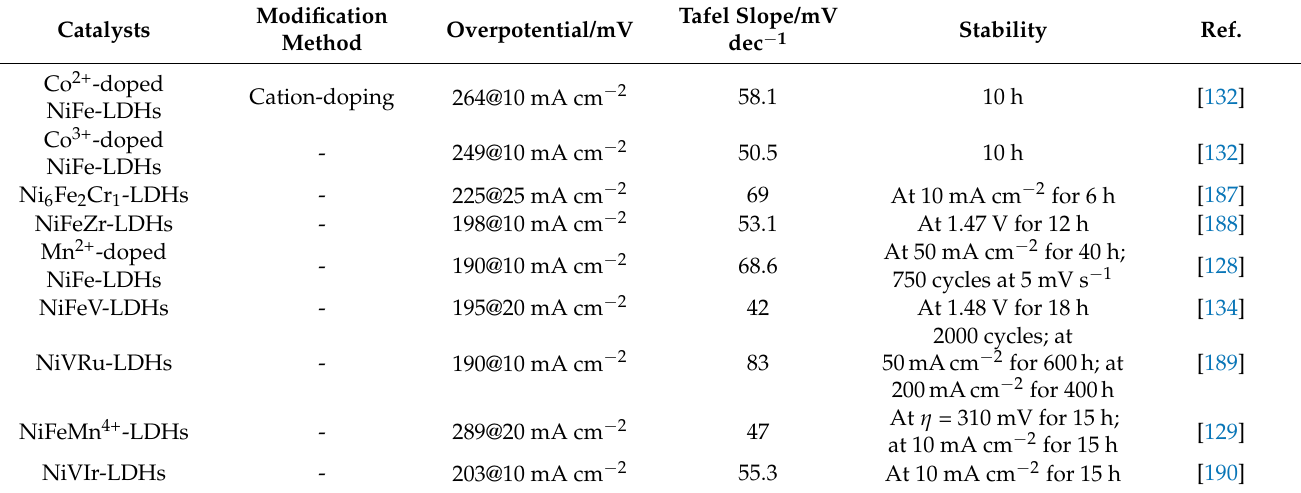
Table 1. Representative LDHs electrocatalysts for the OER process in 1 M KOH electrolyte.